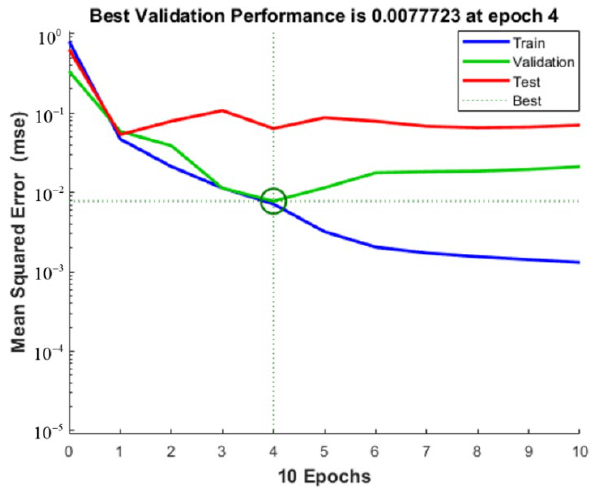
Figure 15. Surface roughness training process curve.